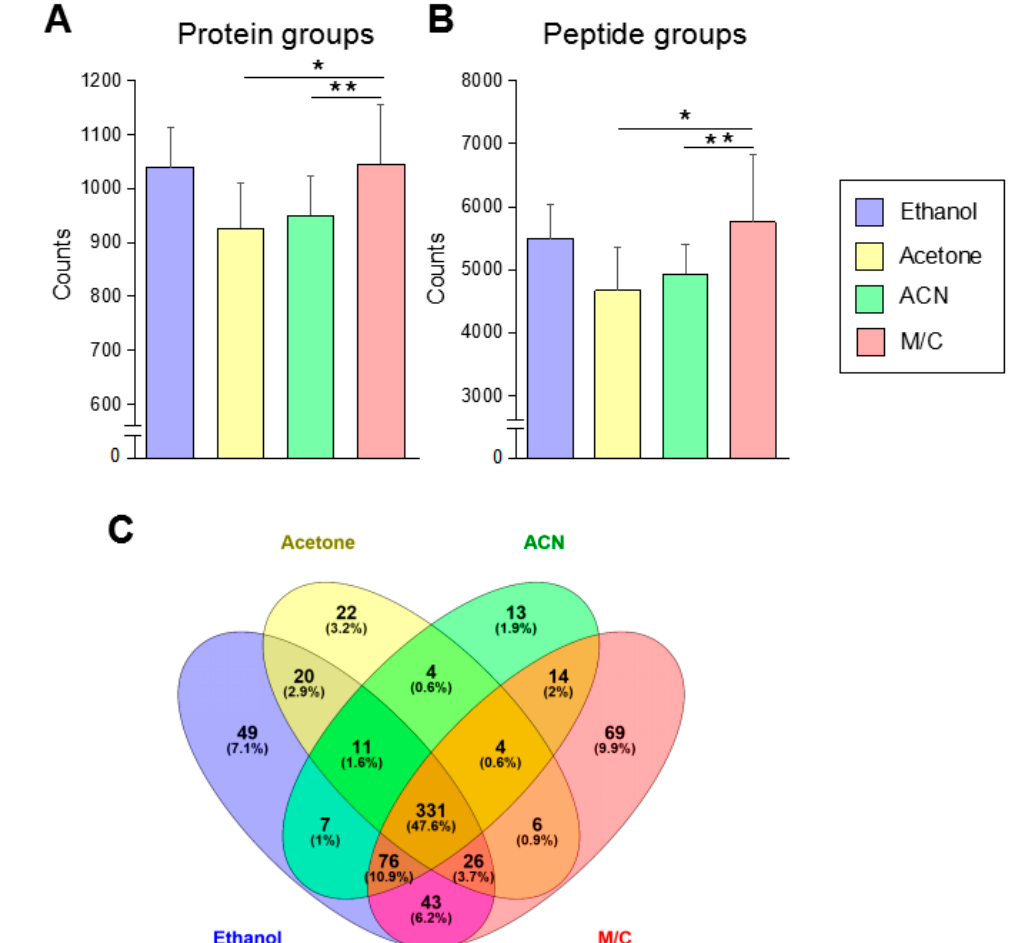
Figure 2. The protein and peptide identification in each precipitation method. ( A , B ) The identification number of protein and peptide. The samples prepared by each precipitation method were analyzed by LC-MS / MS. The proteomic data were analyzed by Proteome discoverer 2.1. Each data was originated from the result in the average of 10 samples. ( C ) The shared and unique protein in each precipitation method. Independent proteomic data provided from each precipitation were analyzed for the isolation of common or unique protein in each group (n = 10). These data were analyzed by Venny 2.1 to make a Venn diagram to indicate shred protein and unique protein between four di ff erent precipitation methods. The Student’s t -test was used to analyze data for significant di ff erences. Values of * p < 0.05, ** p < 0.01 were regarded as significant. ACN: acetonitrile; M / C: methanol /